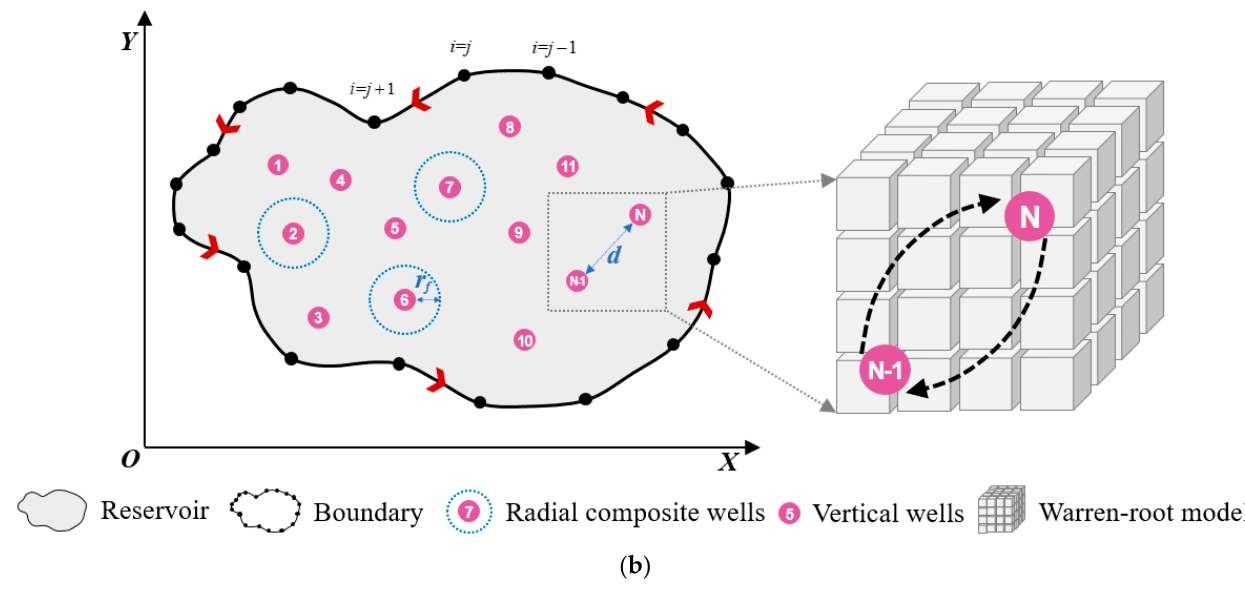
Figure 1. Physical model of the multi-well system with well interference in UGS. ( a ) Schematic diagram (modified from Uniper [31]); ( b ) the multi-well system and reservoir media.